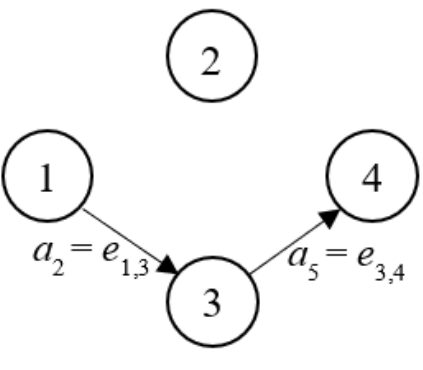
Figure 4. G ( X 10 ) and X 10 = (0, 1, 0, 0, 1).